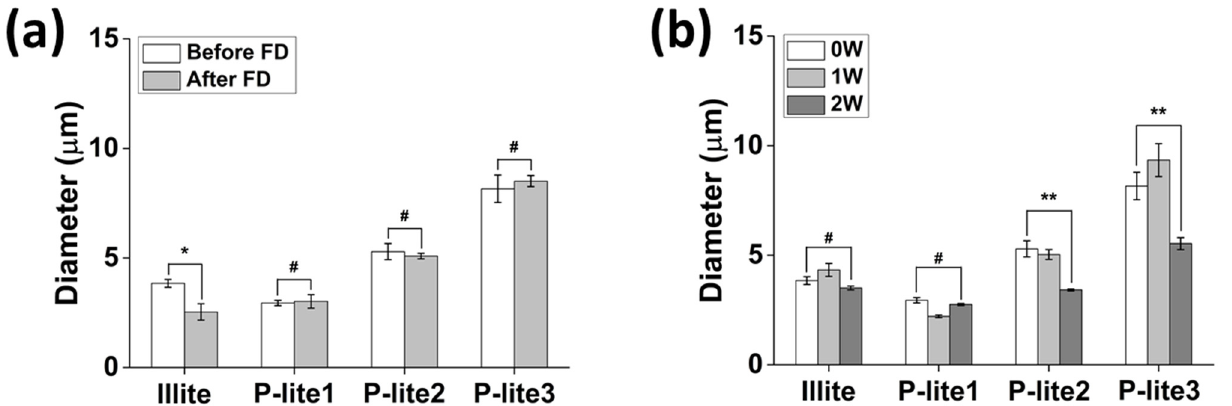
Figure 5. Stability analysis of illite and P-lite MPs in a biological buffer at 37 ◦ C. ( a ) Change in diameters of illite and P-lite MPs after lyophilization and redispersion in phosphate-buffered saline. ( b ) Hydrodynamic diameters of illite and P-lite MPs after 2 weeks of storage at 37 ◦ C. PVP, polyvinylpyrrolidone; P-lite MP, PVP-stabilized illite microparticles; P-lite1, 1:5 weight ratio of illite:PVP; P-lite2, 1:10 weight ratio of illite:PVP; P-lite3, 1:20 weight ratio of illite:PVP; FD, freeze-drying; 0W, 0 weeks; 1W, 1 week; 2W, 2 weeks; # p > 0.05; * p < 0.05; ** p <